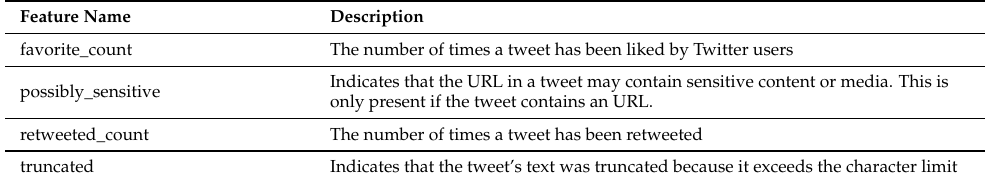
Table A3. Overview of the status attributes returned by the Twitter API directly adopted as tweet features.